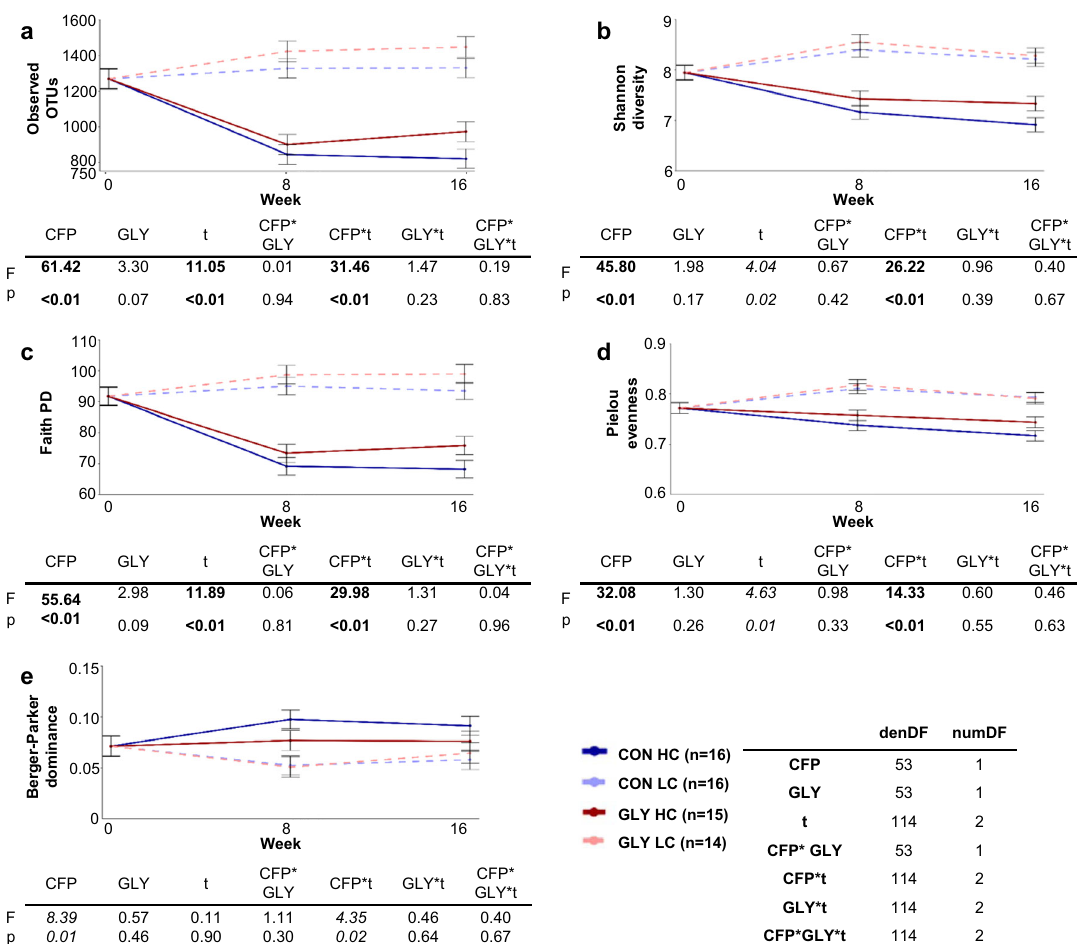
Fig. 2 In fl uences of concentrate feed proportion and glyphosate on rumen microbial alpha-diversity. In fl uences of concentrate feed proportion (CFP) and glyphosate on observed operational taxonomic units (OTUs) in the rumen ( a ), the Shannon index of the rumen microbial community ( b ), and rumen phylogenetic diversity displayed as Faith ’ s phylogenetic diversity ( c ). In addition, evenness of the rumen microbial community as Pielou index ( d ) and dominance in the microbial displayed by Berger – Parker index ( e ) are depicted. Displayed are group lsmeans together with their respective standard error and the results of one-tailed ANOVAs of linear mixed effects models with fi xed factors CFP, glyphosate exposure (GLY), time ( t ), and the interactions for the individual parameters. Number of individuals ( n ) and degrees of freedom were identical for all parameters and are displayed in the fi gure. Blue: control diet (CON), red: glyphosate contaminated diet (GLY), dark solid lines: high CFP (HC), light dashed lines: low CFP (LC), denDF: denominator degrees of freedom, numDF: numerator degrees of freedom, values in bold: p < 0.01, values in italics: p < 0.05.